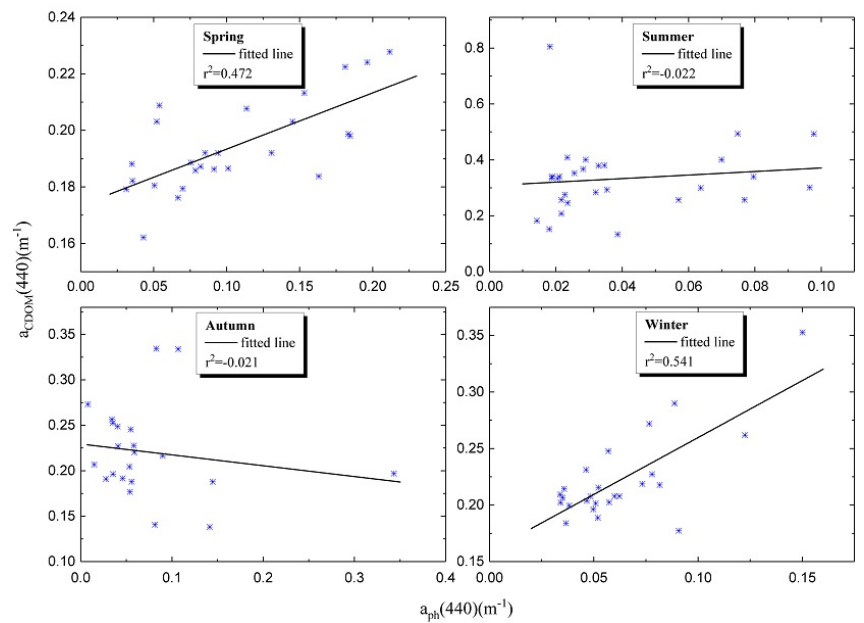
Figure 10. Scatterplot of a ph ( 440 ) against a CDOM ( 440 ) and the corresponding least-squares fitted line in different seasons.